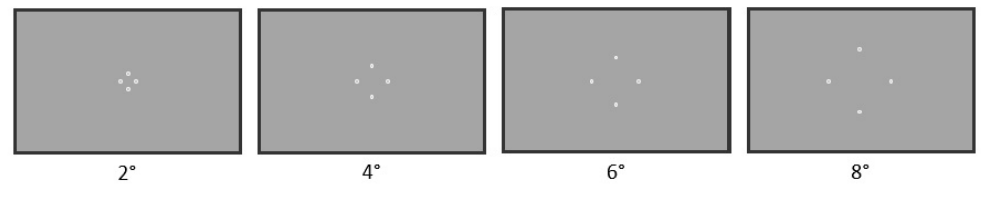
Figure 2. The layout of circles depending on the item distance from the center of the display plane. The illustration is not to